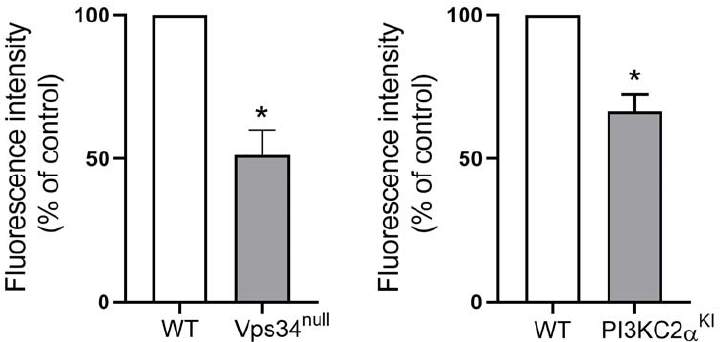
Figure 5. Class III PI 3-kinase (Vps34) and Class II PI 3-kinase α contribute to the external PI3P pool on platelets. To investigate the role of class III PI3-kinase (Vps34) and class II PI3-kinase α in the formation of the external PI3P pool on platelets, platelets were isolated from wild type (WT), Vps34-deficient megakaryocyte/platelet (Vps34 null ), and heterozygous kinase dead class II PI 3-kinase α (PI3KC2 α KI ) mice. These fixed washed platelets were then incubated with the FYVE probe (25 µ g/mL) and analyzed using confocal imaging. The fluorescence intensity was quantified using the ImageJ software from a total of 280 WT, 260 Vps34 null , and 215 WT and 89 PI3KC2 α KI in 3 independent experiments. The results are expressed as a percentage of control (WT platelets). Wilcoxon test compared the different conditions to control, * p ≤